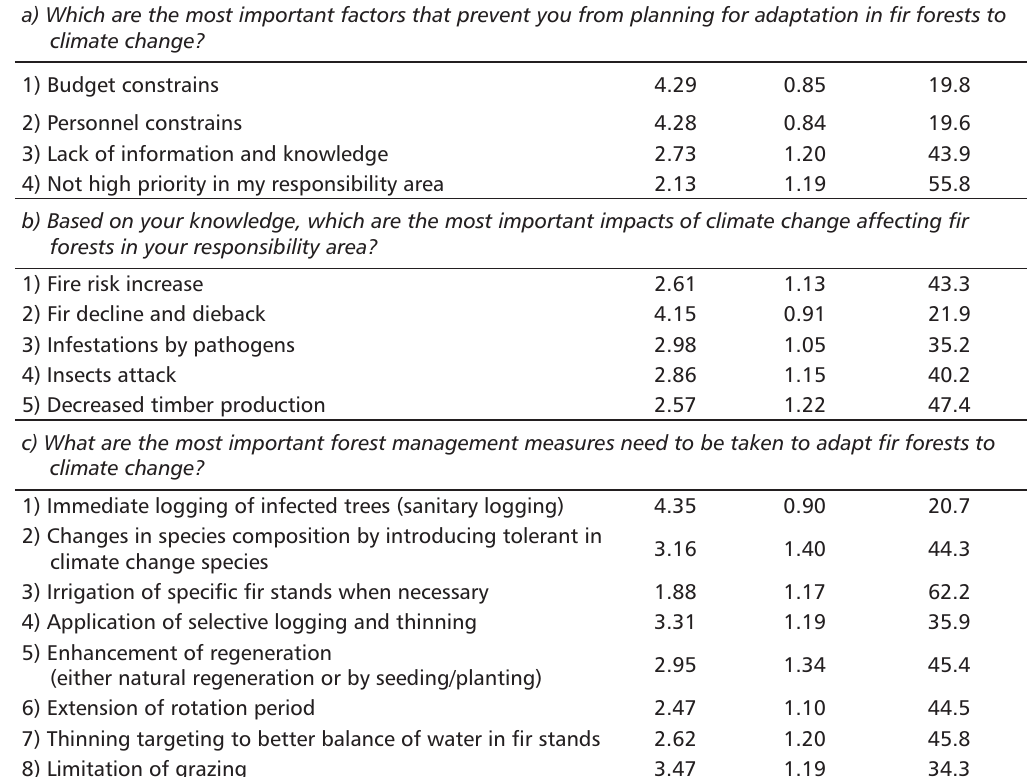
TABLE 2. Perspectives of climate change as risk to fir forests Perception